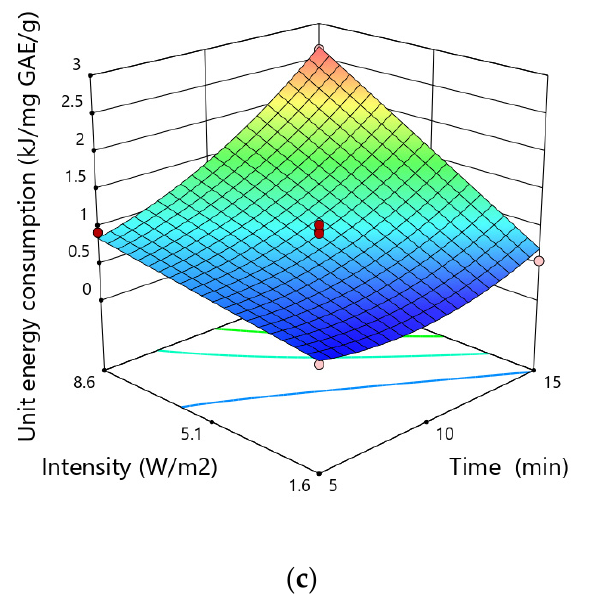
Figure 5. Response surfaces for the unit energy consumption (kJ ∙ mg − 1 GAE ∙ g − 1 ) in hemp showing the effect of ( a ) time and size particle, ( b )size particle and intensity, ( c ) intensity and time. Given the p -values of each equation coefficients, it could be confirmed that three linear terms ( X 1 , X 2 and X 3 ), two quadratic terms ( X 12 , X 22 ) and two interactive terms ( X 1 X